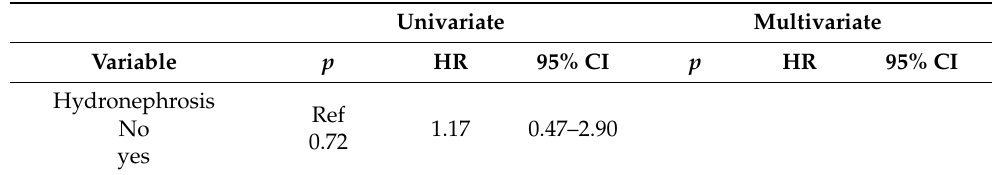
Table 6. Cox regression for factors associated with